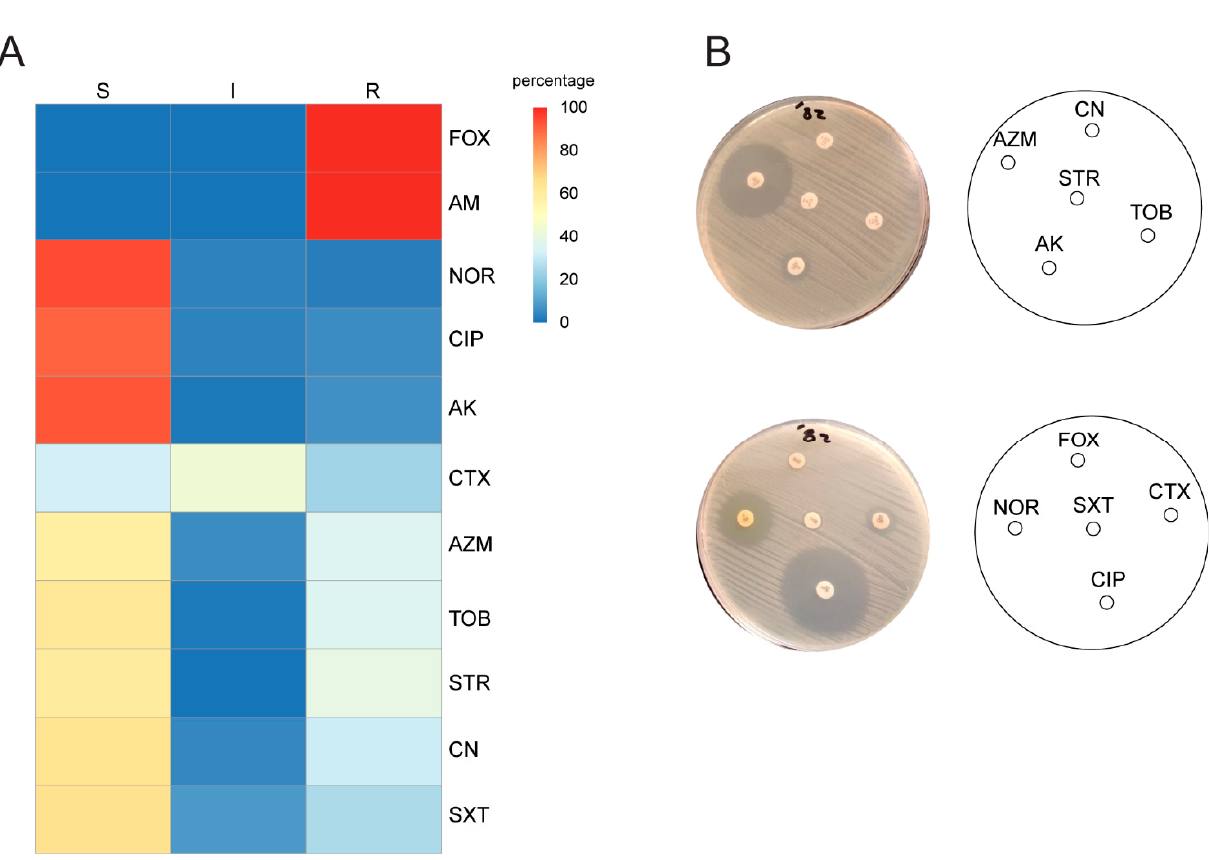
Figure 2. Antimicrobial susceptibility of MRSA isolates: ( A ) representative heatmap depicting the observed antibiogram for the S. aureus isolates to different antimicrobial chemotherapeutics. Cefoxitin (FOX), ampicillin (AM), cefotaxime (CTX), ciprofloxacin (CIP), norfloxacin (NOR), amikacin (AK), tobramycin (TOB), gentamicin (CN), streptomycin (STR), azithromycin (AZM), and sulfamethoxazole/trimethoprim (SXT). Sensitive (S), intermediate resistant (I), resistant (R). The heatmaps were created using R version 4.0.1 with the package ggplot2 version 3.3.1 [23]; the heatmap matrix was retrieved from scored susceptibility identified by DDM in ( B ). ( B ) Antimicrobial susceptibility of S. aureus isolates against different antibiotics by DDM.